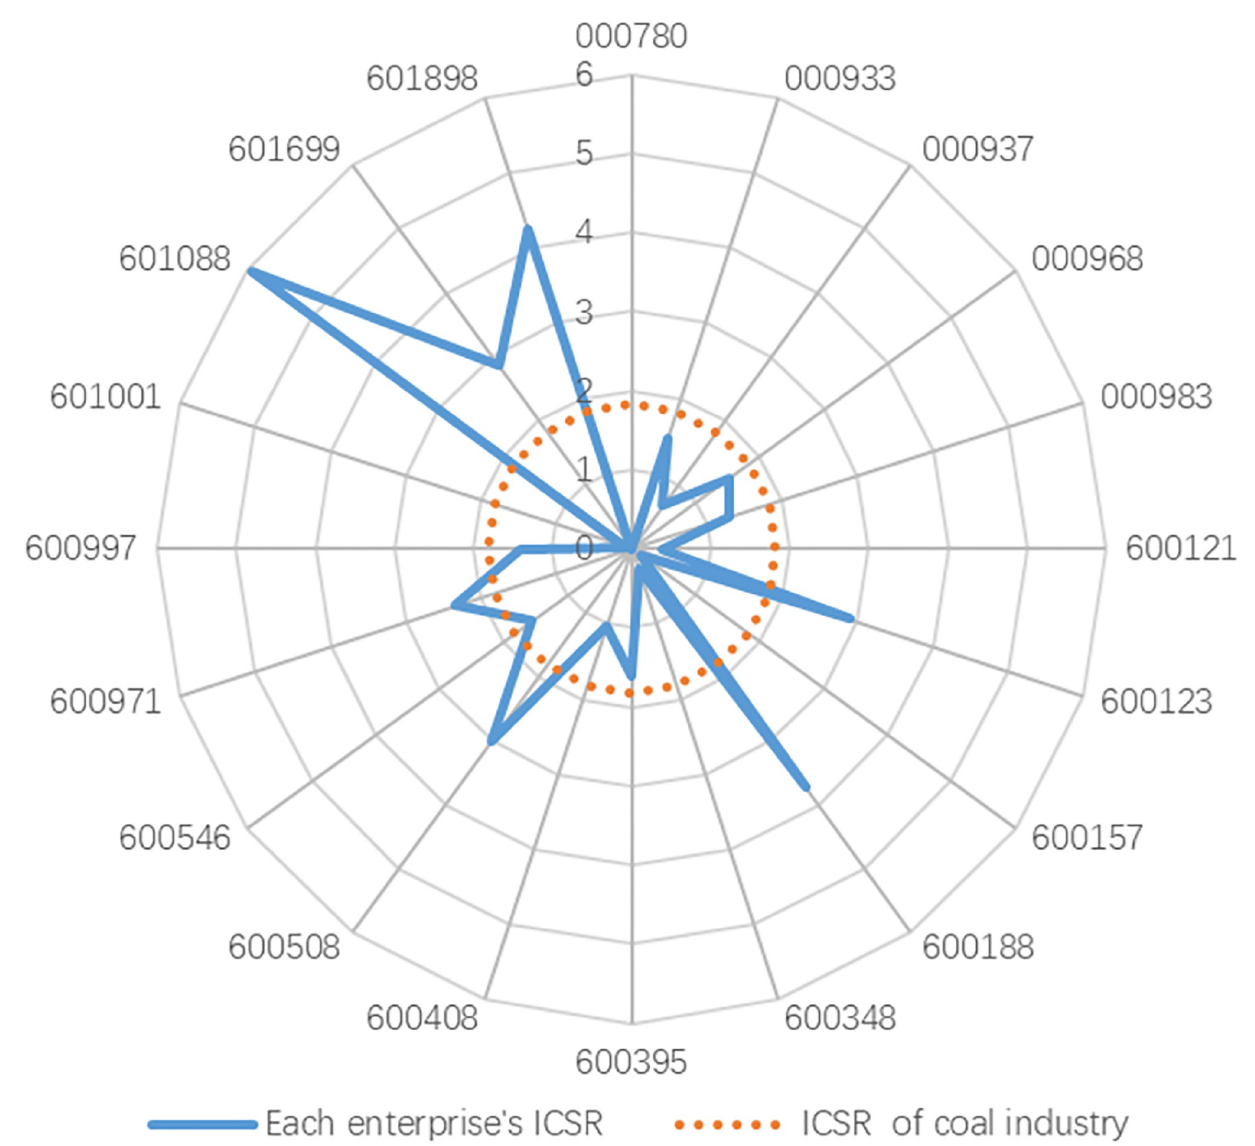
Fig 7. Each enterprise’s average ICSR of the Chinese coal industry,